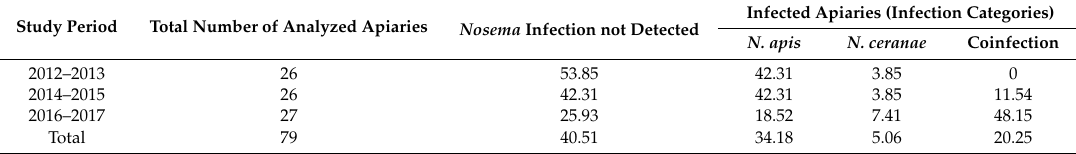
Table 3. Spreading of Nosema species in apiaries of the sub-taiga zone from 2012 to 2017. Study